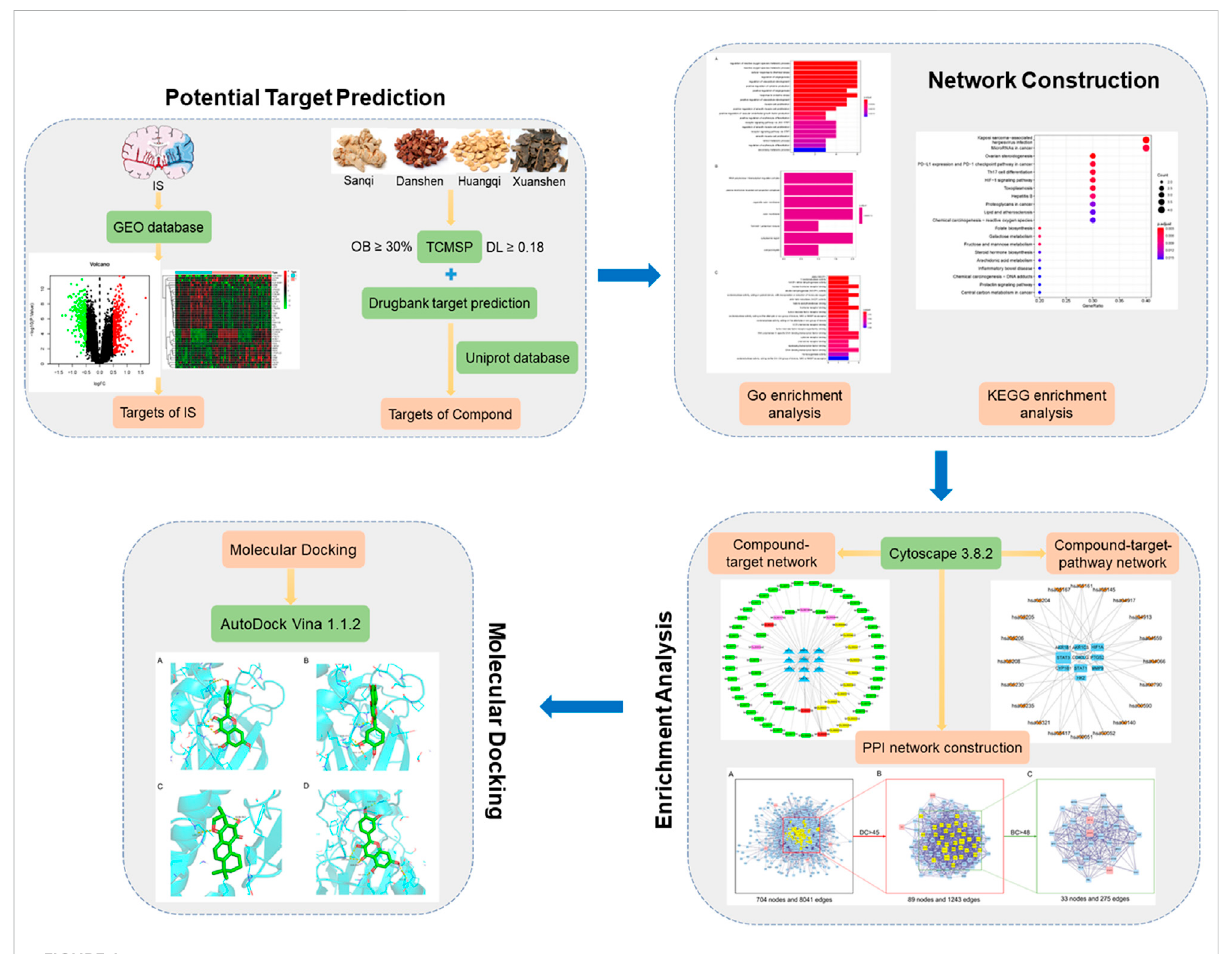
FIGURE 1 Speci fi c process of network pharmacology